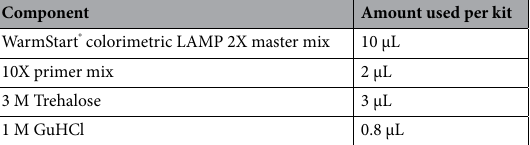
Table 1. Optimized formulation of the lyophilized colorimetric RT-LAMP test.